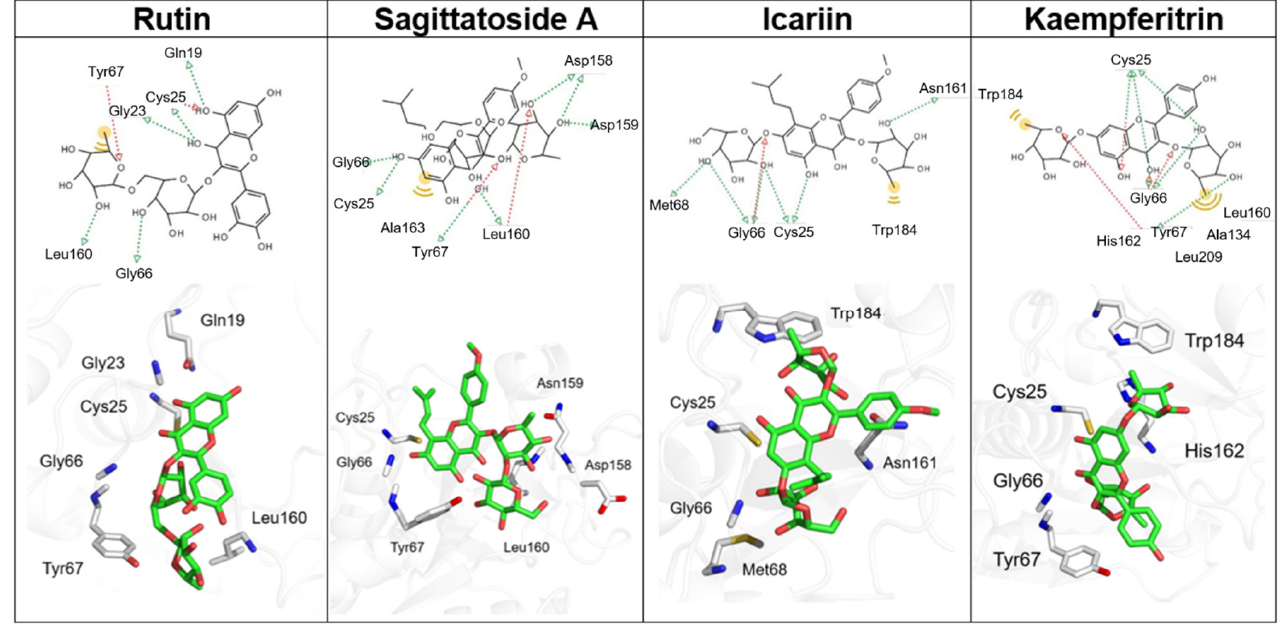
Figure 6. The 2D and 3D binding poses of candidates in a binding site of Cathepsin K. Ligands (green) are bound with amino acids (white) at the binding site. The pharmacophore features are represented as green arrows (HBD), red arrows (HBA), and yellow spheres (hydrophobic property).